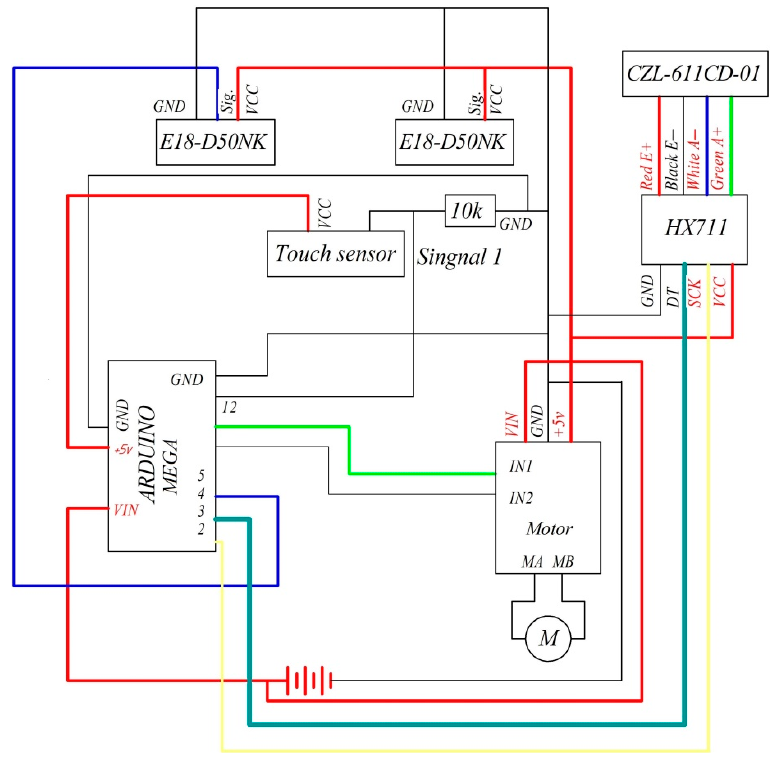
Figure 11. Connection scheme of the sensors and motor.